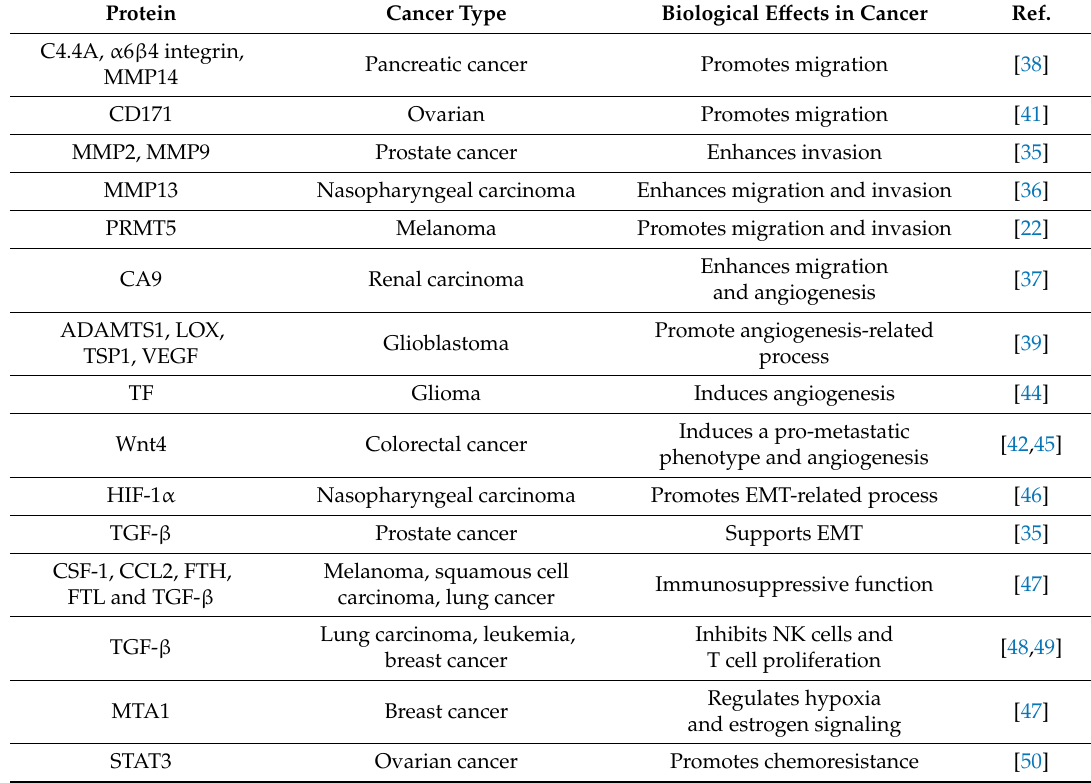
Table 1. Proteins enriched in sEVs derived from hypoxic cancer